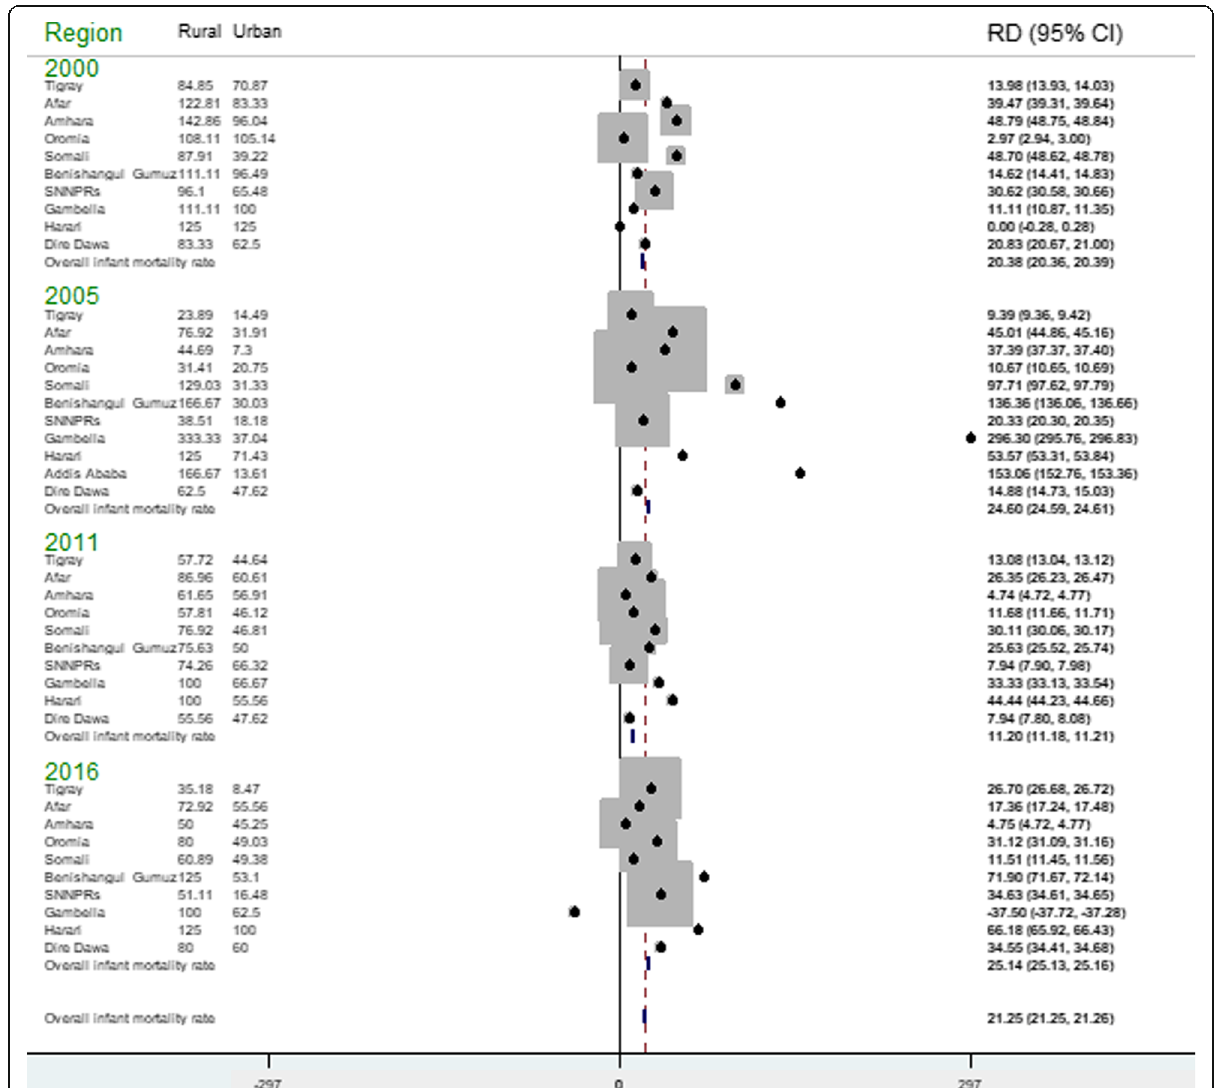
Fig. 1 Forest plot of urban-rural risk difference of infant mortality across regions in Ethiopia over